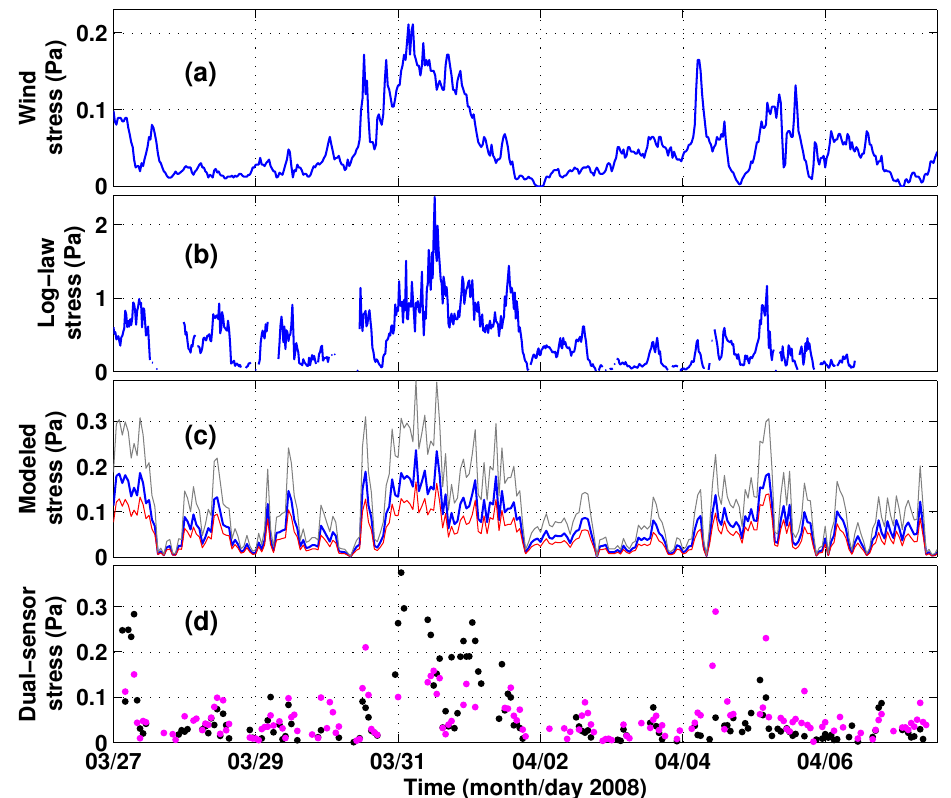
Figure 6. Time-series of ( a ) wind stress; ( b ) bottom stress estimate based on the log-law of the wall; ( c ) bottom stress based on the bottom boundary layer model [12] (grey, blue, and red curves correspond to model calculations with k s = 10 − 3 m, 10 − 4 m, 10 − 5 m, respectively); ( d ) direct estimates of near-bed stress based on the dual-sensor method (black dots denote East–West component of stress; magenta dots denote North–South component of